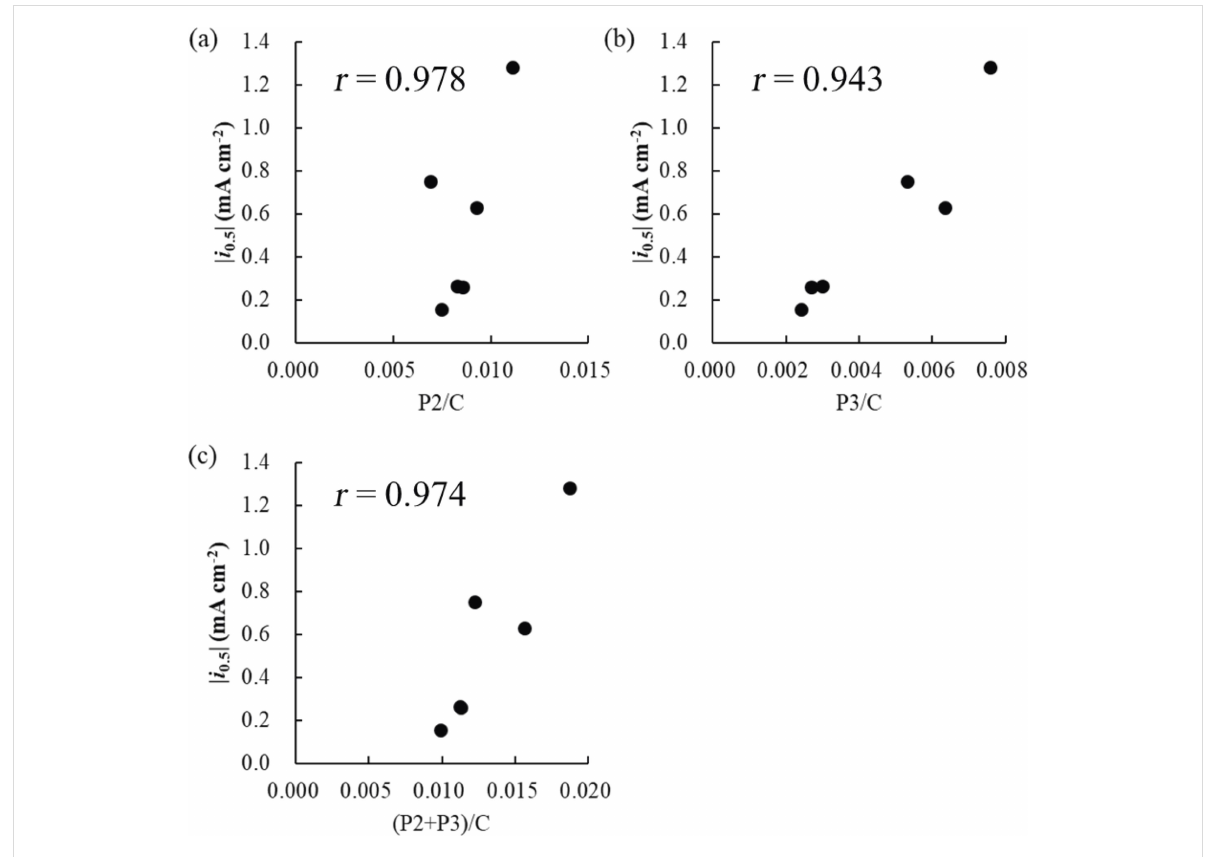
Figure 9: Correlation of the ORR activity (represented by i 0.5 ) with (a) P2/C, (b) P3/C, and (c) (P2+P3)/C molar ratios.